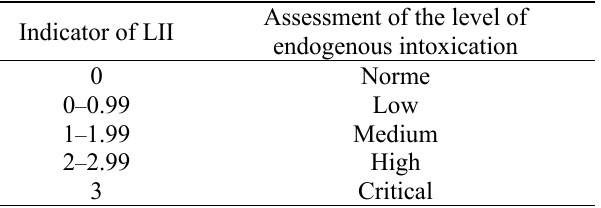
Identification and assessment of the intensity of